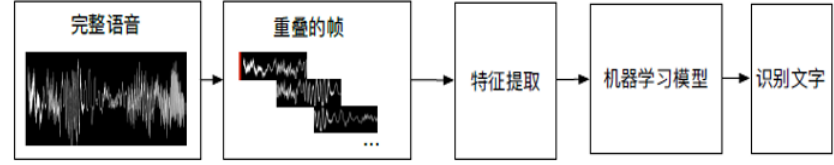
Fig. 3. Cmu sphinx speech recognition system model [4]